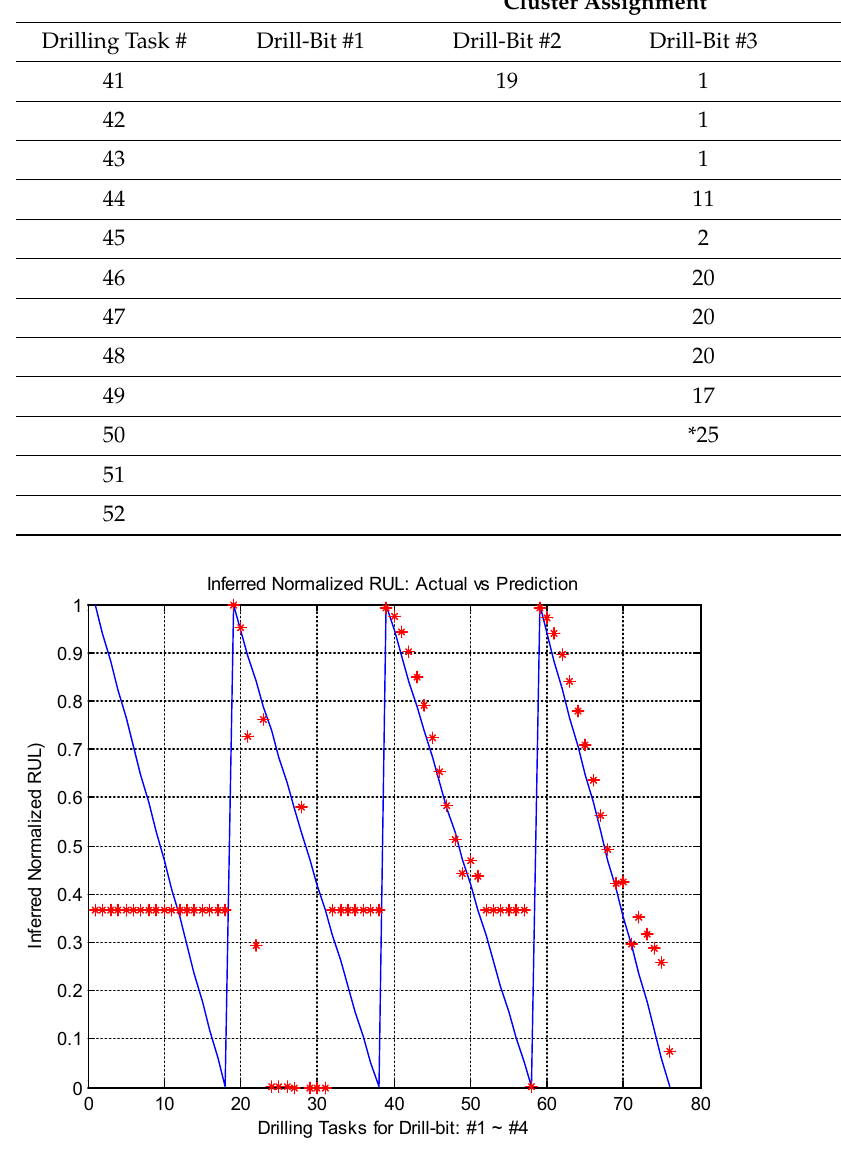
Figure 8. Normalized inferred RUL (blue line) vs. predicted RUL (red dotted line) for drill-bits #1~#4 in a delayed online setup.